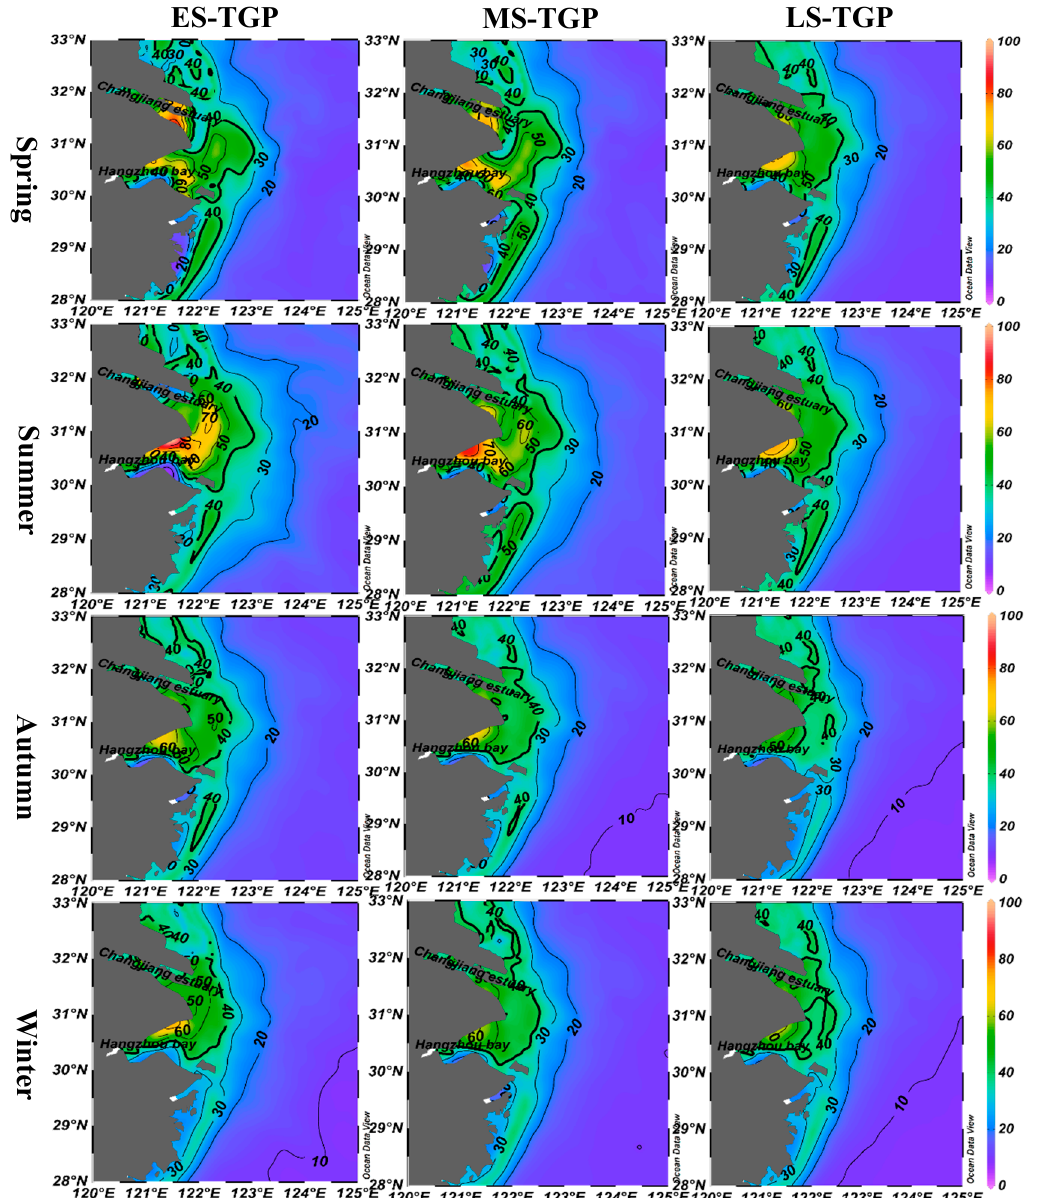
Figure 6. Seasonal surface distribution of the POC around the Changjiang Estuary and adjacent ECS during the TGP periods based on the model simulation results. The bold curve represents a POC value of 40 μ mol L − 1 .